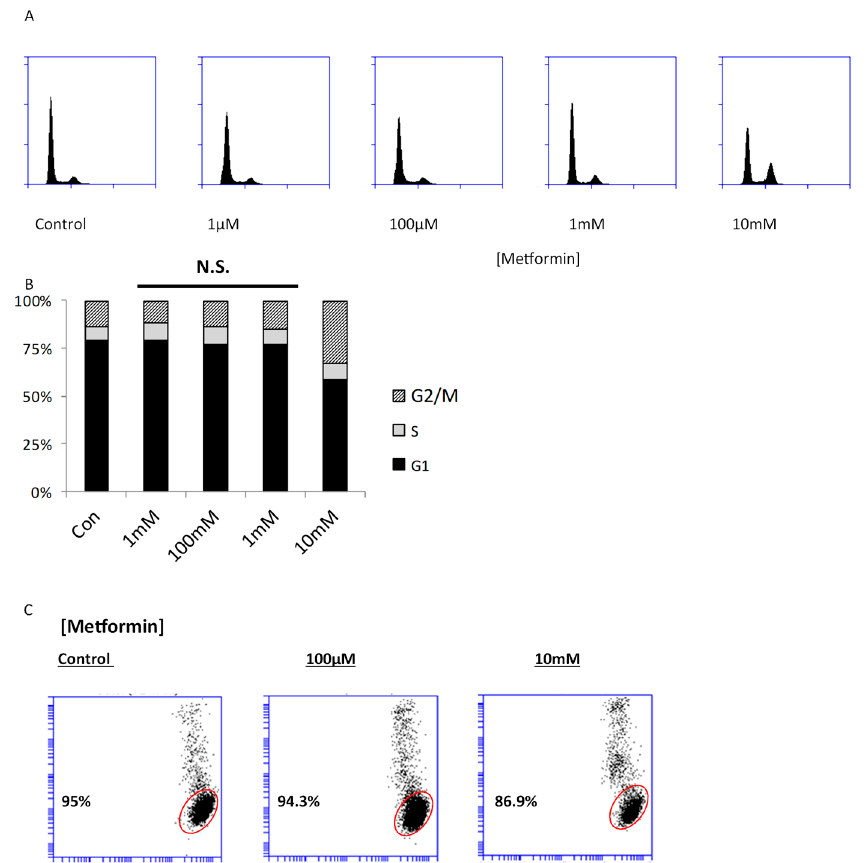
Figure 1. Metformin fails to directly impact breast cancer cell viability at pharmacologically relevant concentrations. ( A ) MDA-MB-231 breast cancer cells were cultured in the presence or absence of metformin for 72 h. Nuclear DNA content was assessed by propidium iodide staining, and analyzed by flow cytometry. The proportion of cells in each phase is depicted in ( B ). In ( C ), cells were cultured in presence or absence of metformin for 48 h, followed by incubation in Sytox Red cell toxicity stain. The dye is excluded from viable cells whose membranes are not compromised (indicated in red).